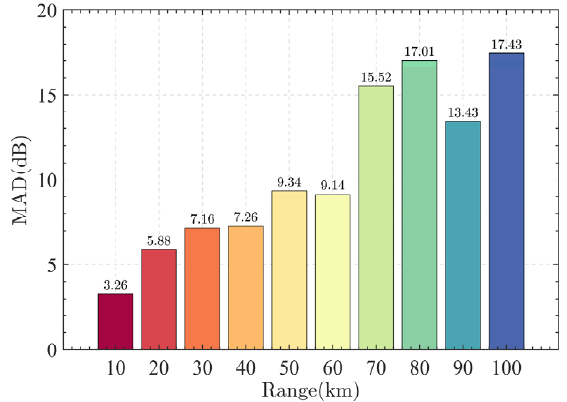
Figure 9. MAD values at different locations on sea surface.